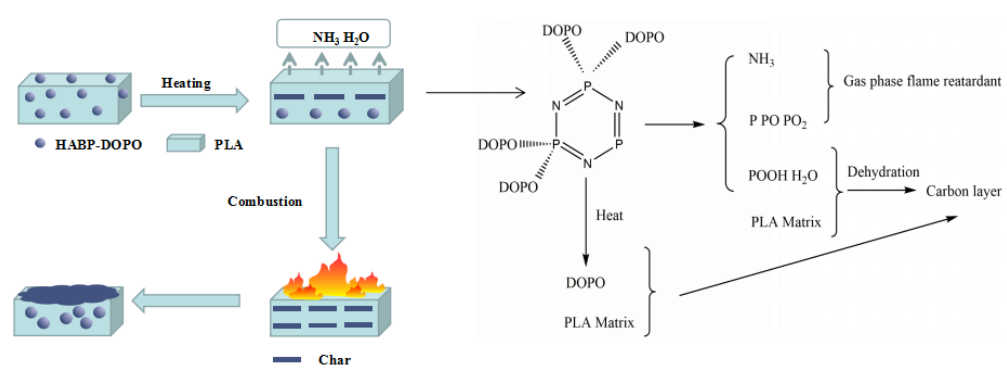
Figure 13. Flame retardant mechanism of PLA / HABP-DOPO blends.